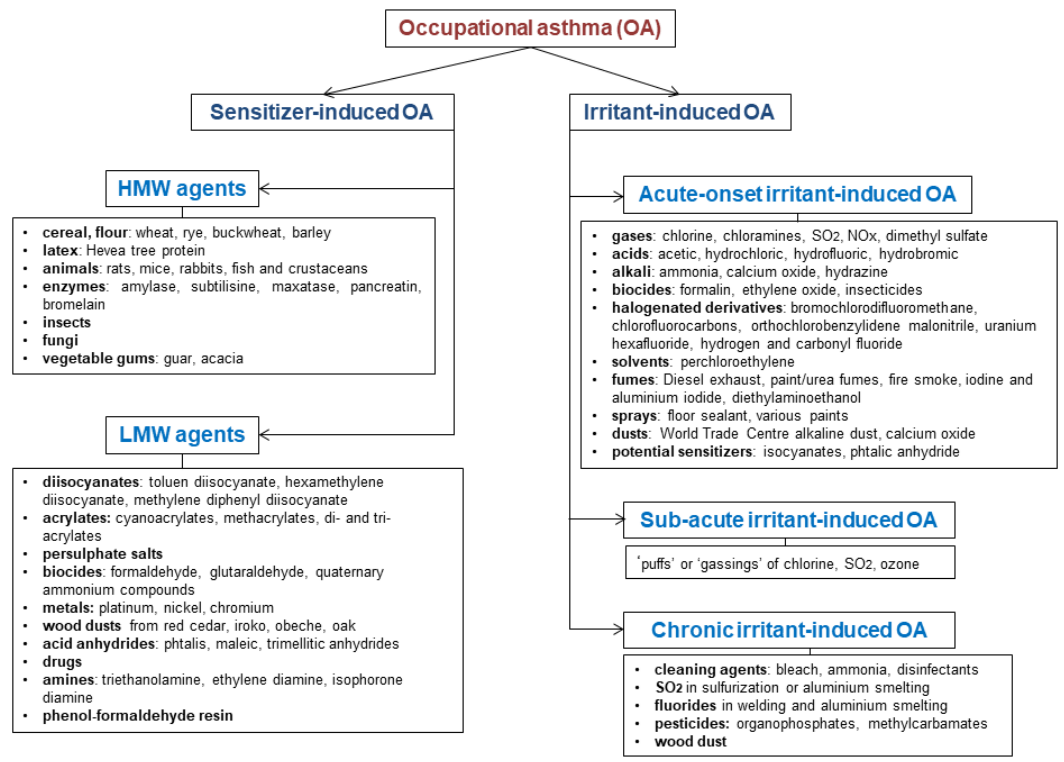
Figure 1. Classification of occupational asthma and the most frequent causal agents; HMW: high-molecular weight; LMW: low-molecular weight.